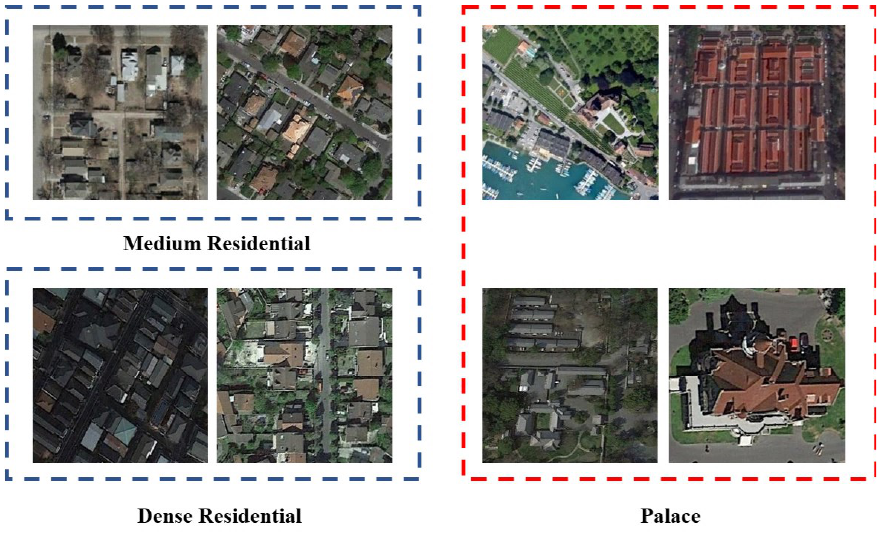
Figure 1. Images from